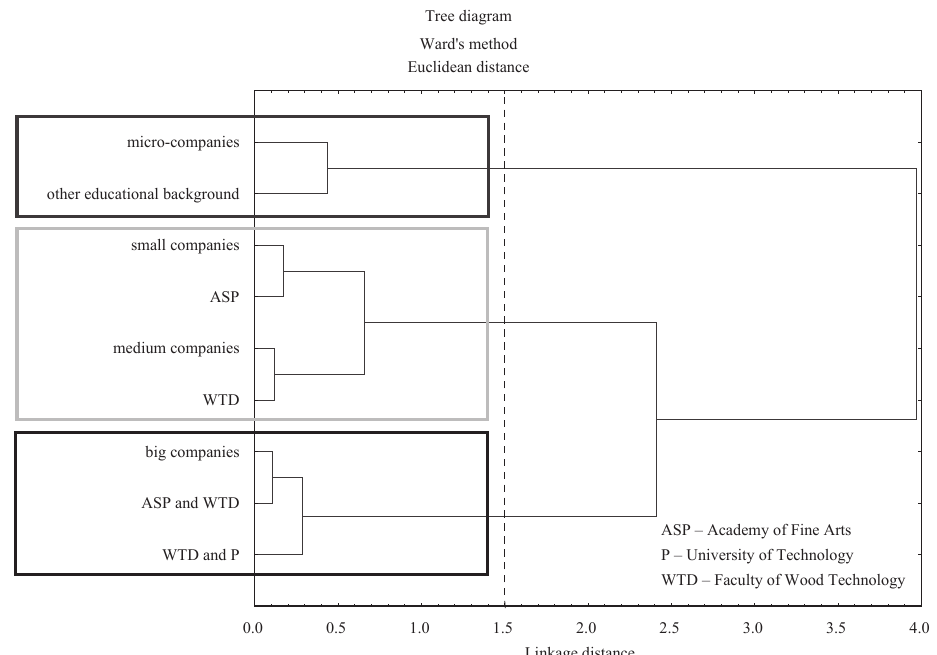
Figure 9 Graphic presentation of results of cluster analysis for variables: size of enterprise and vocational training of individuals designing